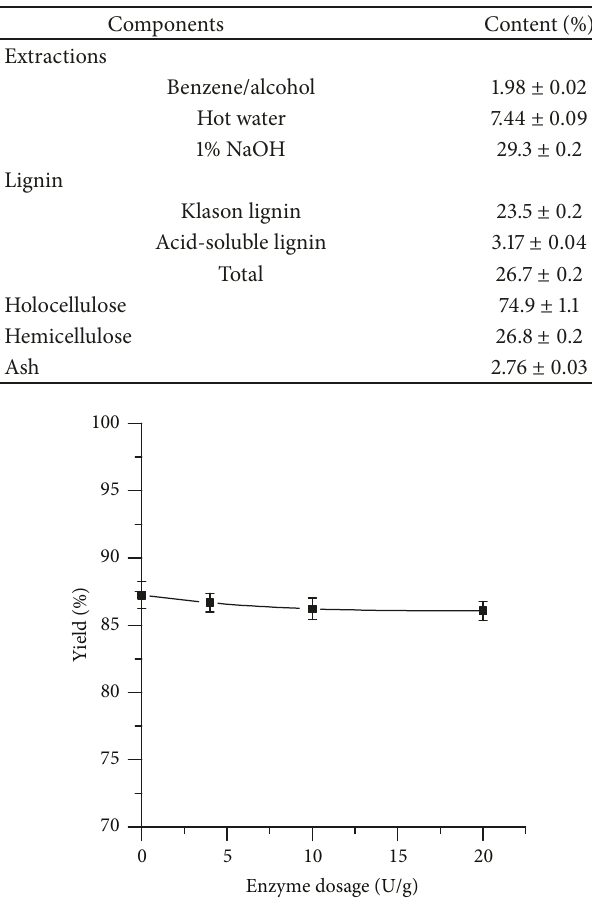
Table 1: Chemical components in the whole stem of mulberry branch.